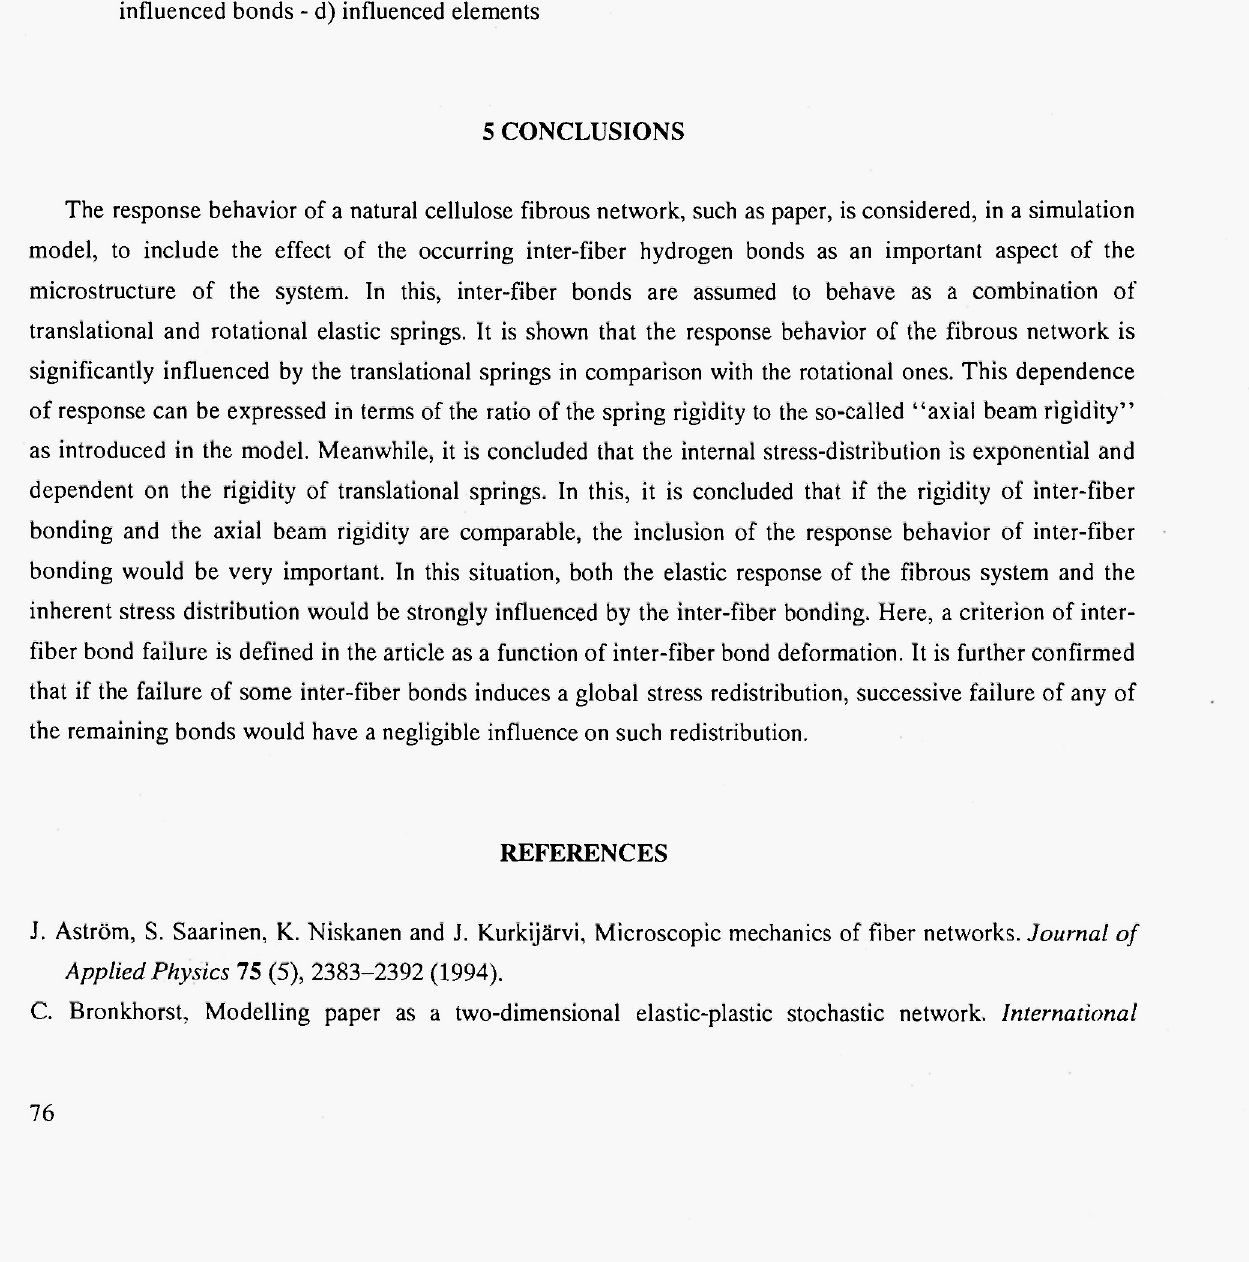
Fig. 12: "Arbitrary" broken bond influence: a) bond deformation difference - b) element stress difference - c) influenced bonds - d) influenced